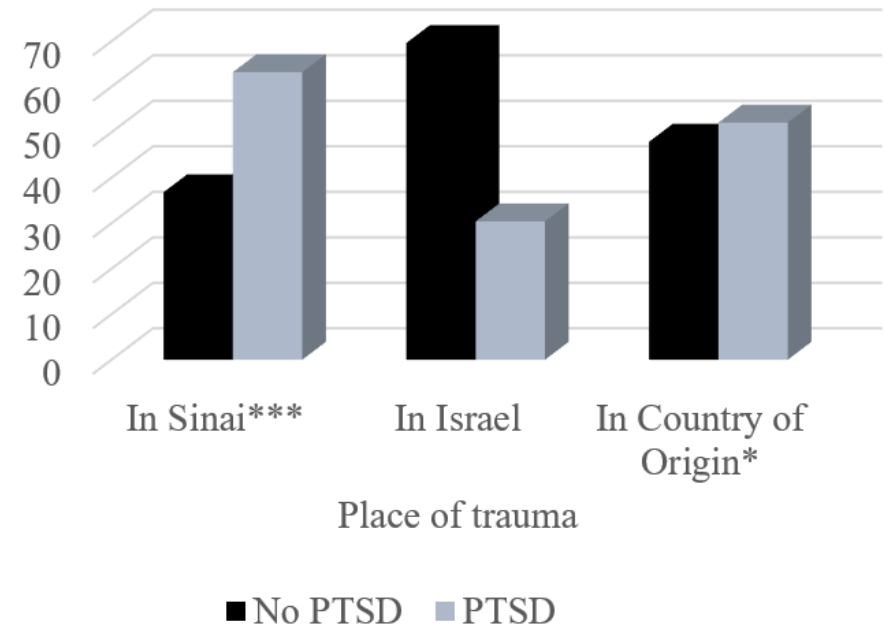
Figure 1. Percentage of asylum seekers with PTSD across place of trauma. *** Significant at p < 0.001, * Significant at p < 0.05. PTSD = Post-traumatic stress disorder.